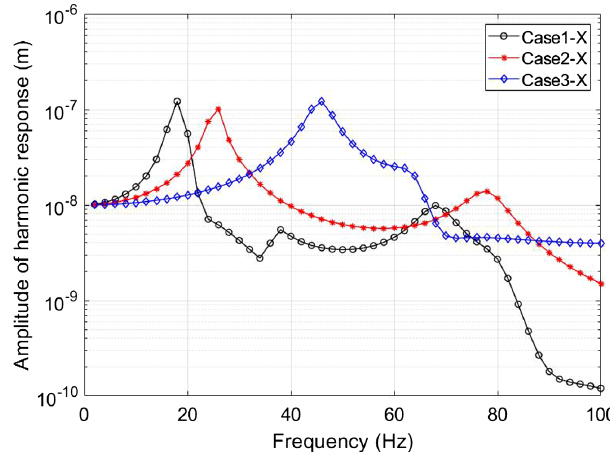
FIG. 5. First-order FEA mode shapes of the magnet-girder assembly prototype, in the cases of (a) case 1, (b) case 2, and (c) case 3.